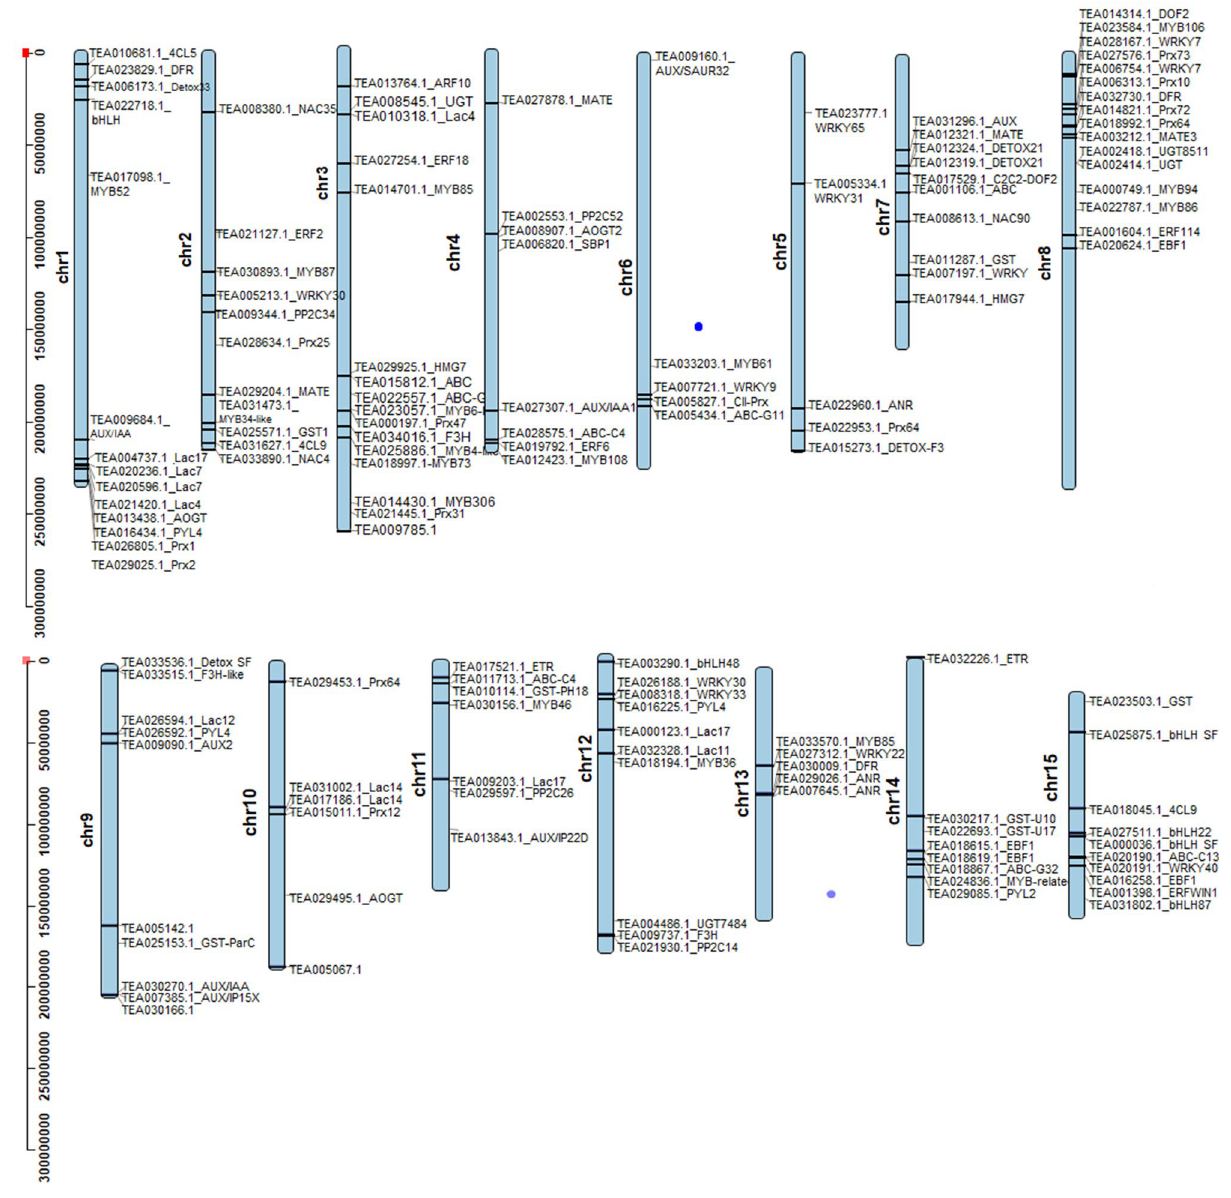
Figure 5. Chromosomal distribution of DEGs involved in anthocyanin biosynthesis and degradation in